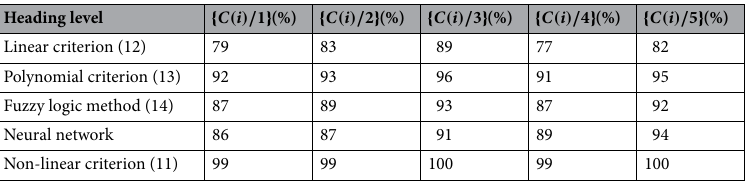
Table 4. The results of the diagnostics of cardiovascular diseases { C ( i )/ k } , k = 1, 5 (% of correct diagnoses).